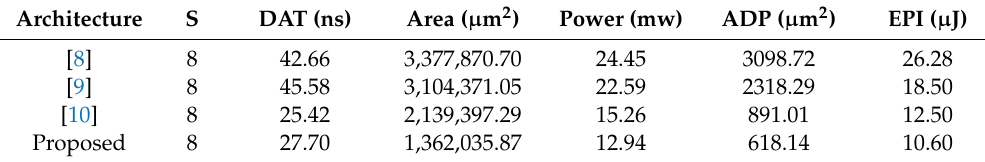
Table 3. Synthesis results of 3-level 2-D architecture for 9 / 7 filter with 512 × 512 image